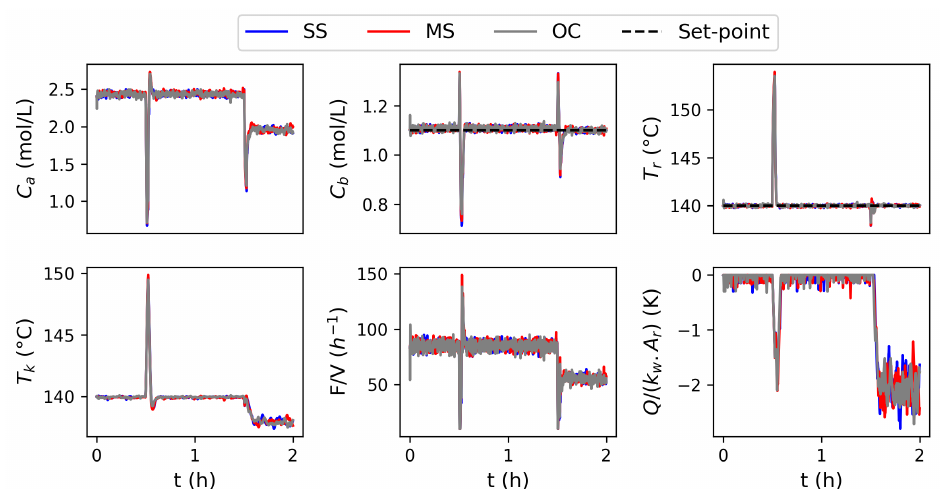
Figure 4. Results for the three NMPC approach for Case 4, considering changes in T in . Table 4. Mean squared error values for the three NMPC methods and all cases analyzed.